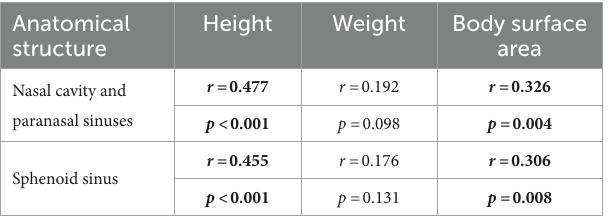
TABLE 3 Pearson’s correlation coefficient for the general characteristics of the patients. Anatomical structure